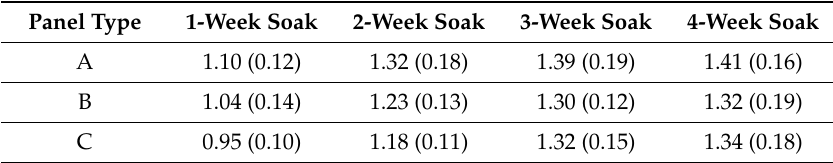
Table 2. Water absorption values of the samples in percentages (numbers in parentheses are standard deviation